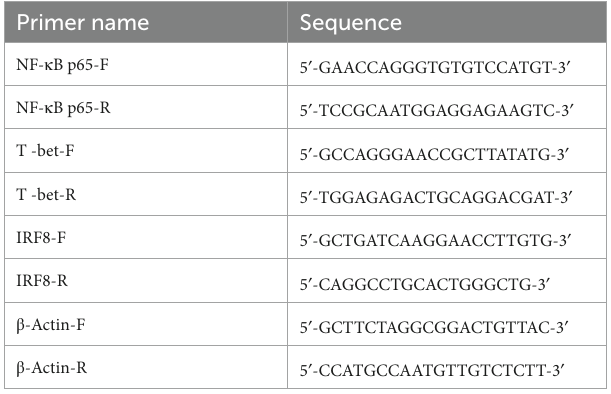
TABLE 1 RT -PCR primers used to amplify the NF- κ B p65, T-bet, IRF8, and β -actin genes designed by primer premier